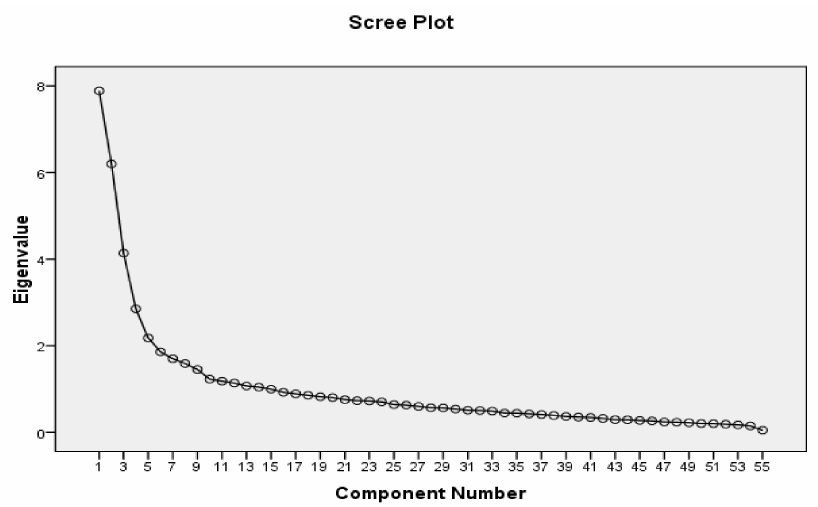
Figure 1. Scree plot for The Delayed Childbearing Questionnaire (DCBQ-55) ( n =